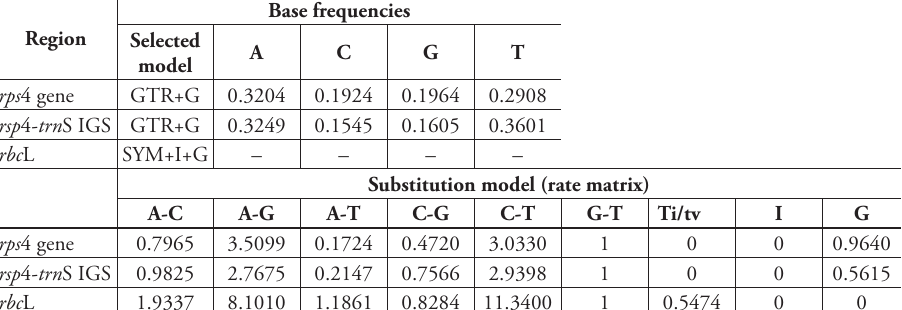
Table 1. Selected models and parameter values for data partitions used in this study. Base frequencies Region Selected A C G T model rps 4 gene 0.3204 0.1924